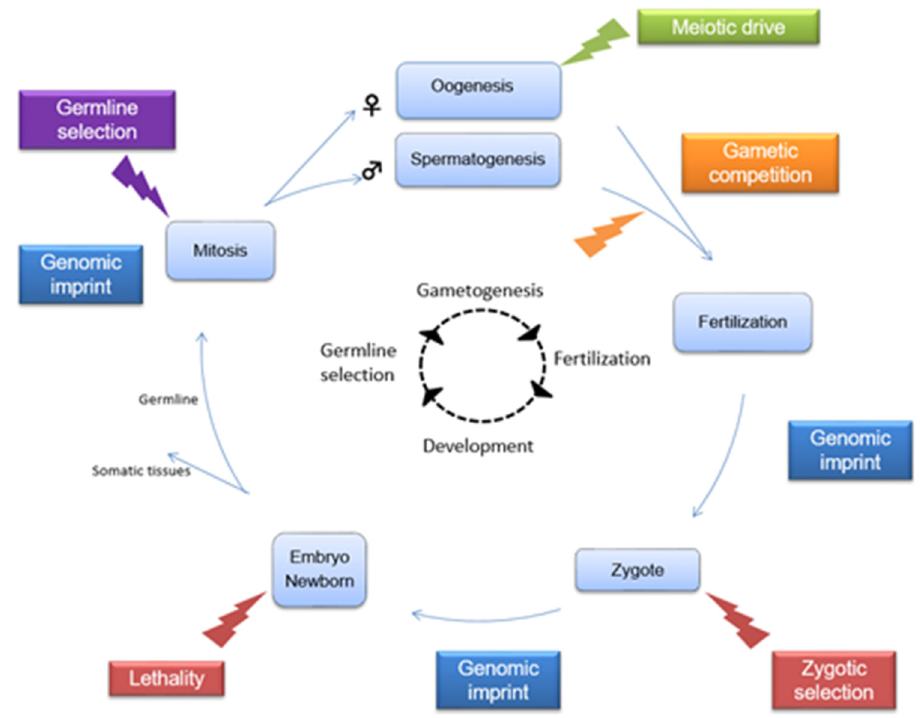
Figure 1. The different biological mechanisms inducing a transmission ratio distortion ranging from gamete formation to lethality at post-natal stages: Germline selection (purple box): During mitosis, mutations, mitotic gene conversion and crossing-overs can occur, causing a germline selection prior to meiosis. Meiotic drive (green box): Selfish genetic elements (meiotic drivers) can bias the normally random segregation of chromosomes in asymmetric division, such as in oogenesis. Gametic competition (yellow box): Before fertilization, there is a competition in mobility and/or viability and/or fertilization ability between spermatozoa. Genomic imprint (blue boxes): Errors in imprints in the parental germline or at fertilization or during the embryonic development can induce TRD. Zygotic selection or embryo/newborn lethality (red boxes): If the genotype is deleterious, it may lead to differential survival of the zygote, the embryo or even of the newborn.